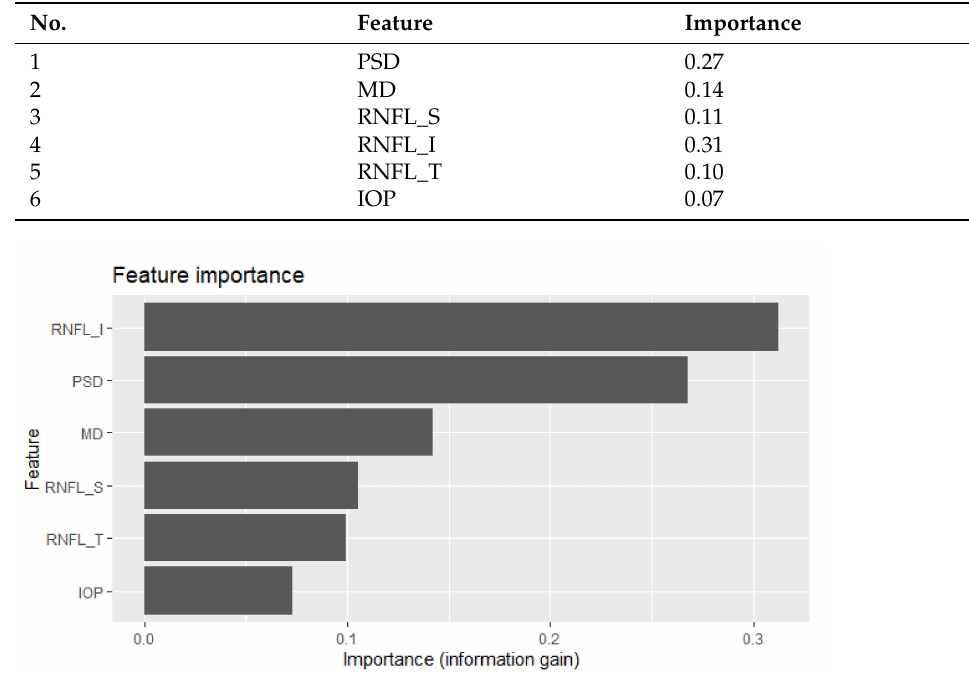
Table 5. Feature importance of the selected features.